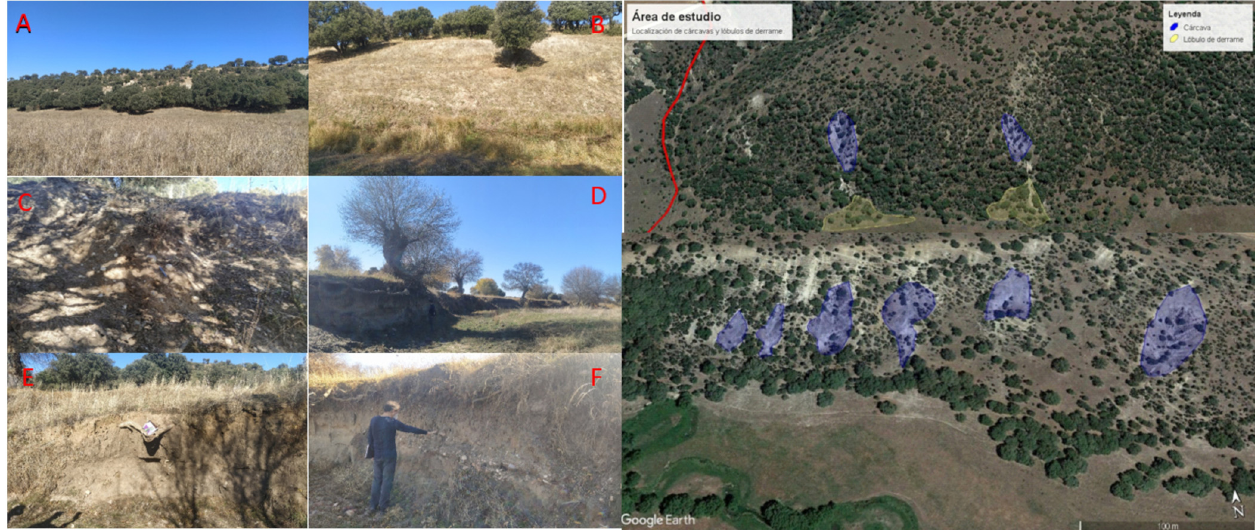
Figure 4. Left . ( A ): Overview of spill cones associated with gullies. ( B ): Detail of front of fans. ( C ): Erosive tracks due to sediment flow. ( D ): Contrast of vegetation present in the study area. ( E ): Visualization of the material carried by the water flow. ( F ): Detail photo corresponding to ( E ). Right . Location in Google Earth of erosive marks such as gullies and their associated spill lobes.